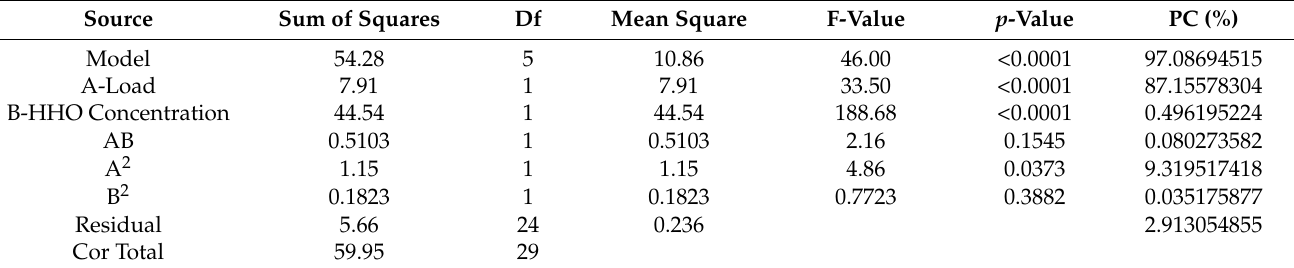
Table 12. ANOVA results for smoke.